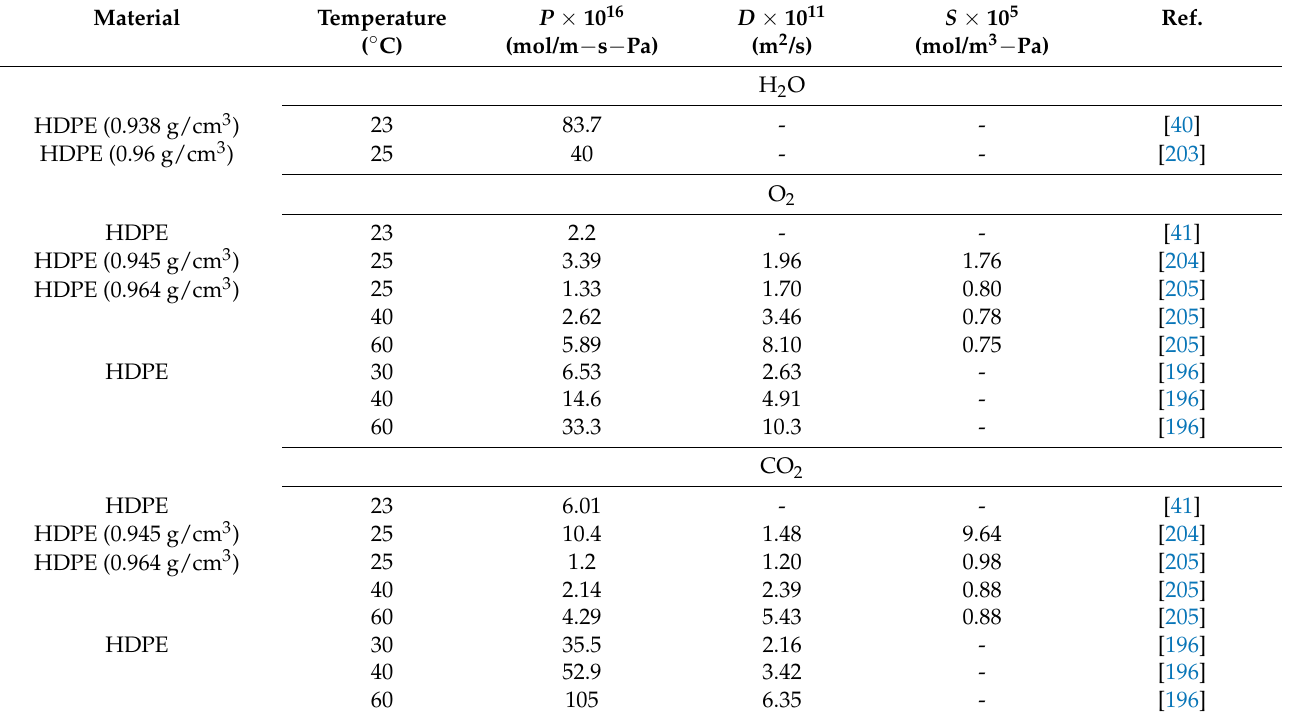
Table 8. Gas transport data for HDPE from the literature